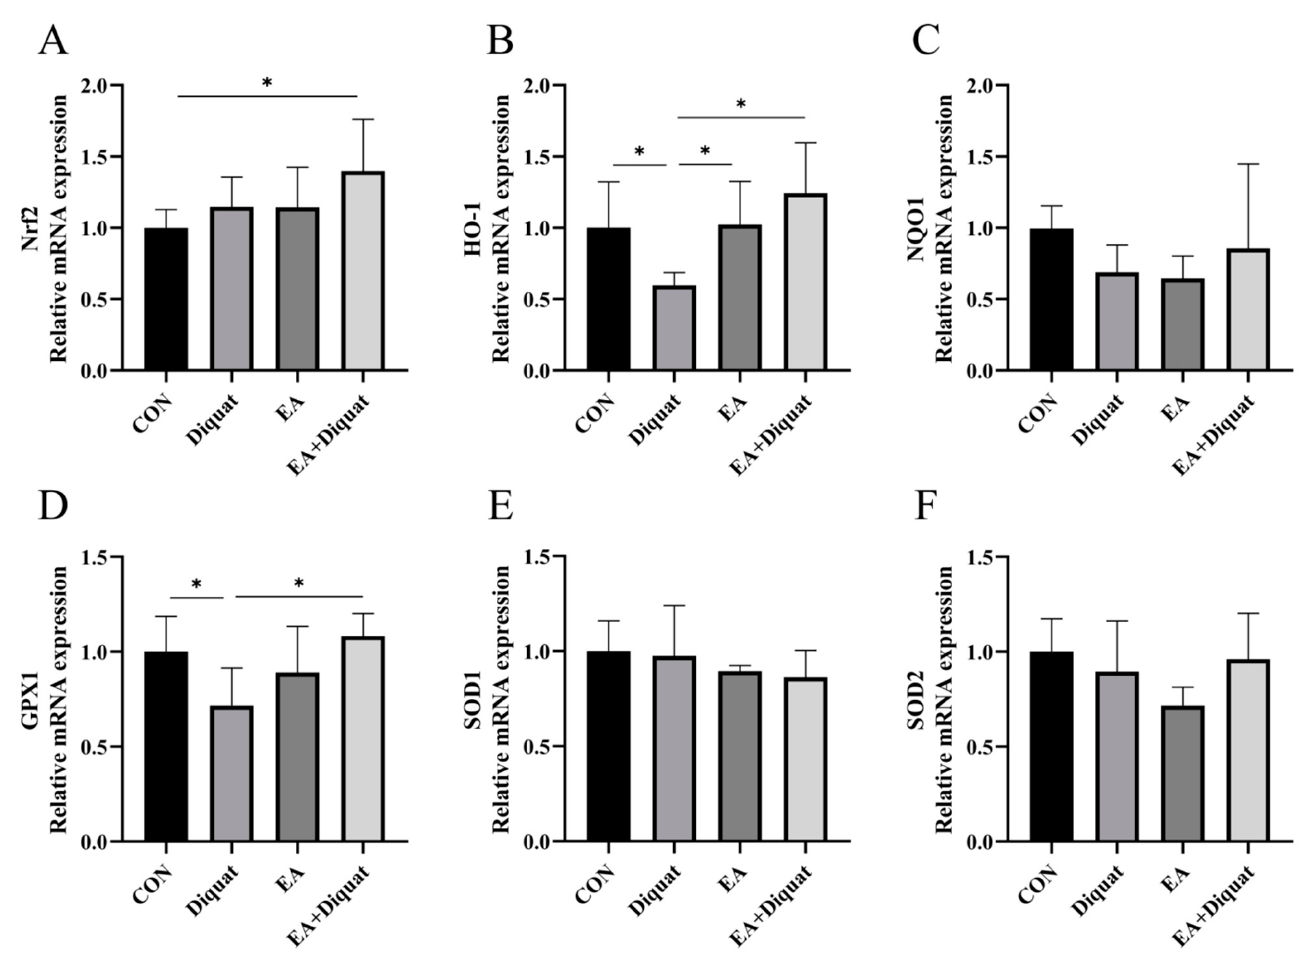
Figure 2. Effects of ellagic acid on antioxidant gene expression in the jejunum when mice were challenged with diquat. ( A – F ) The relative mRNA expression of Nrf2, HO-1, NQO1, GPX1, SOD1 and SOD2. All data were presented as mean ± S.E.M ( n = 6). * means p < 0.05 between the two groups. CON, control; EA: ellagic acid; Nrf2, nuclear factor erythroid 2-related factor 2; HO-1, heme oxygenase-1; NQO-1, NADPH dehydrogenase-1; GPX1, glutathione peroxidase 1; SOD1, superoxide dismutase 1; SOD2, superoxide dismutase